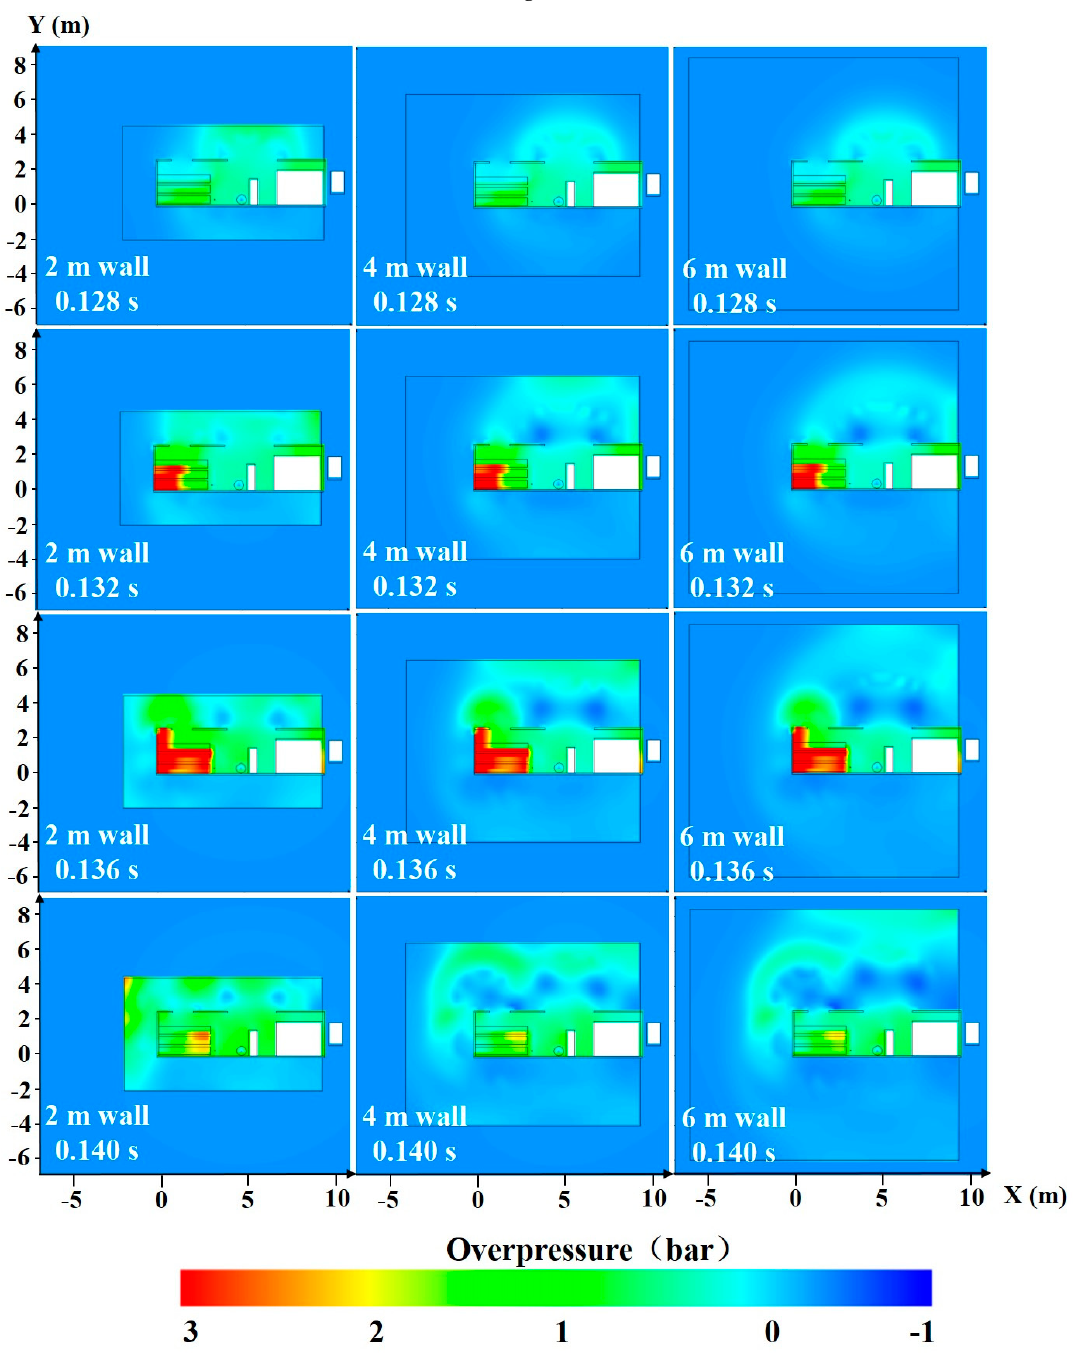
Figure 9. Overpressures at various times for various protective wall distances.